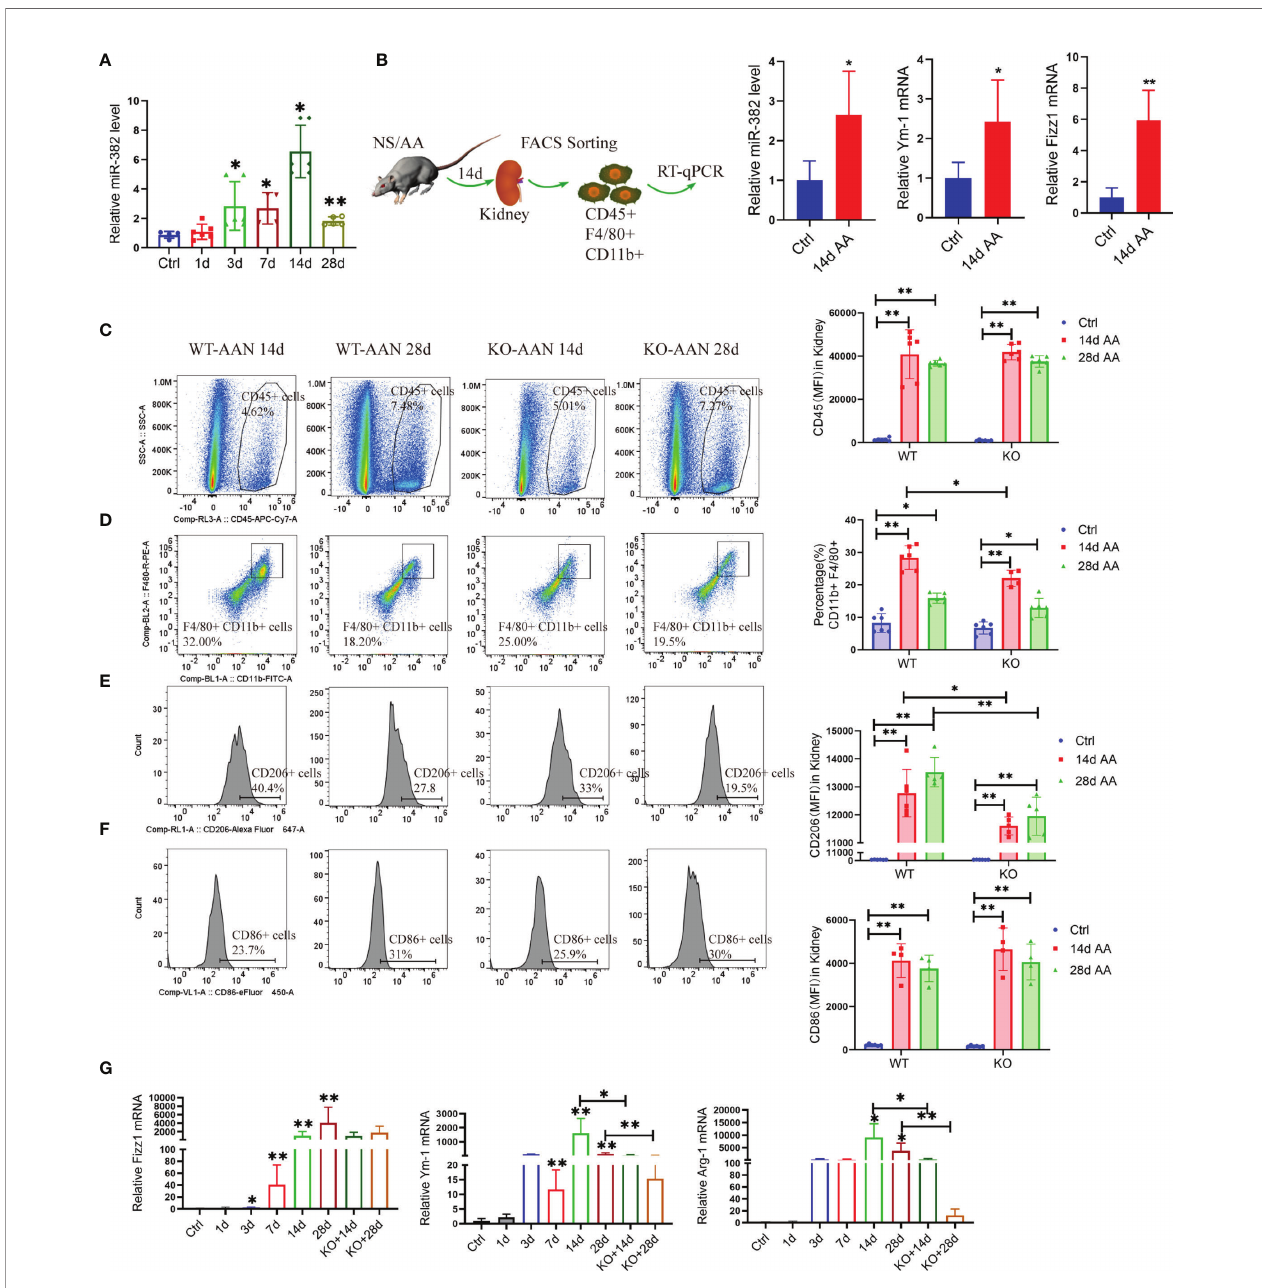
FIGURE 2 | Blockade of miR-382 inhibits M2-like macrophage polarization in the kidney. (A) Relative abundance of miR-382 after intraperitoneal injection of 10 mg/ kg AA at a concentration at 0.5 mg/ml for 1, 3, 7, 14, and 28 days; saline was administered as control treatment. U6 was used as the endogenous control; n = 6 per group. (B) Macrophages were identi fi ed as CD45+CD11b+F4/80+ by fl ow cytometry and isolated from the kidneys from normal and 14 days of AAN. Real-time RT-qPCR was performed in isolated macrophages. Transcripts of miR-382, Fizz1, and Ym-1 of sorting macrophages from normal and fi brotic kidneys (14 days AAN). U6 was used an endogenous control of miR-382, and 18S serves as standard of Fizz1 and Ym-1; n = 3 mice each group. (C) Representative fl ow cytometry plots of CD45+ leukocytes in renal between WT and KO mouse after 14 and 28 days of AAN. Mean fl uorescence intensity (MFI) of CD45 among ctrl and AAN 14 days and AAN 28 days from WT or KO mice. (D) Representative fl ow cytometry plots of CD11b+F4/80+ macrophages in kidney between WT and KO mouse after 14 and 28 days AAN. Percentage of CD11b+F4/80+ macrophages among ctrl and AAN 14 days and AAN 28 days from WT or KO mice. (E) Representative fl ow cytometry images and MFI of CD206+ macrophages between WT and KO mouse after 14 and 28 days AAN. Mean fl uorescence intensity (MFI) of CD206 among ctrl and AAN 14 days and AAN 28 days from WT or KO mice. (F) Representative fl ow cytometry images and MFI of CD86+ macrophages between WT and KO mouse after 14 and 28 days AAN. Mean fl uorescence intensity (MFI) of CD86 among ctrl and AAN 14 days and AAN 28 days from WT or KO mice. (G) Relative mRNA levels of Fizz1, Arg-1, and Ym-1 in renal tissue from control mice, AAN 1, 3, 7, 14, and 28 days mice as well as AAN 14 and 28 days KO mice. 18S was used as an endogenous control; n = 6 mice per group. * P < 0.05; ** P < 0.01;